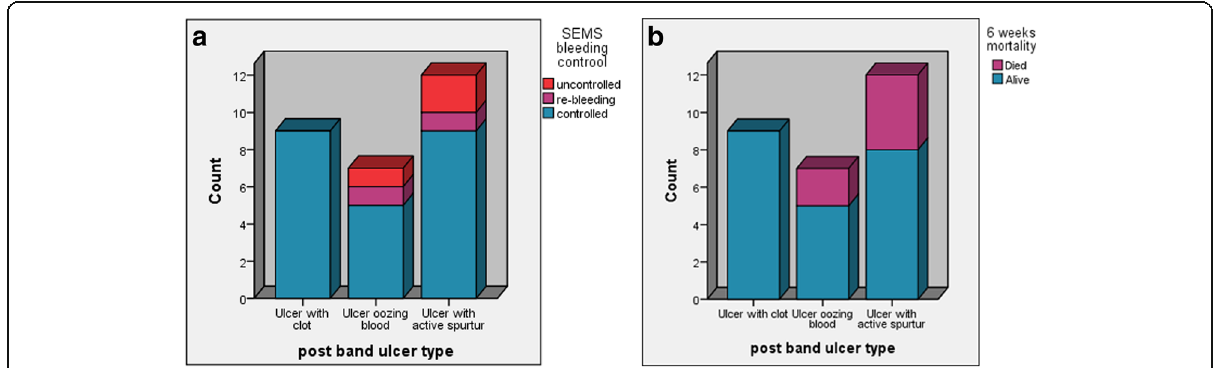
Fig. 2 a Control of bleeding. b Mortality after SEMS deployment according to ulcer